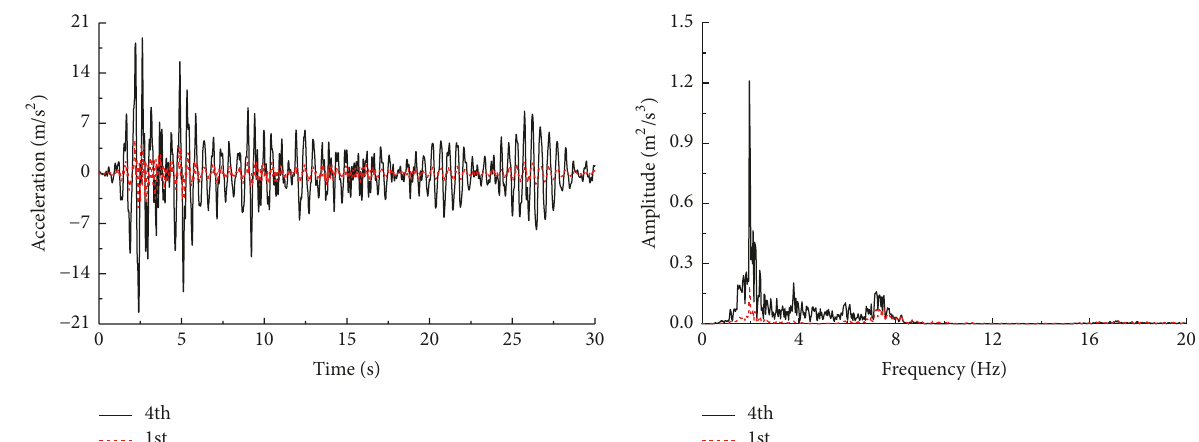
Figure 8: Horizontal acceleration time history and corresponding Fourier spectrum curves at node 103 on the 4th floor and node 18 on the 1st floor under standard case (HV).